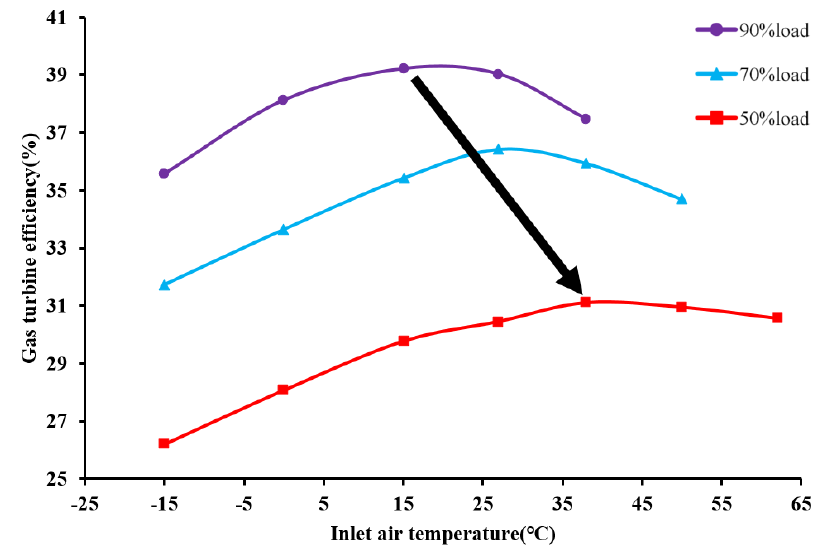
Figure 8. Gas turbine efficiency with varying inlet air temperatures.